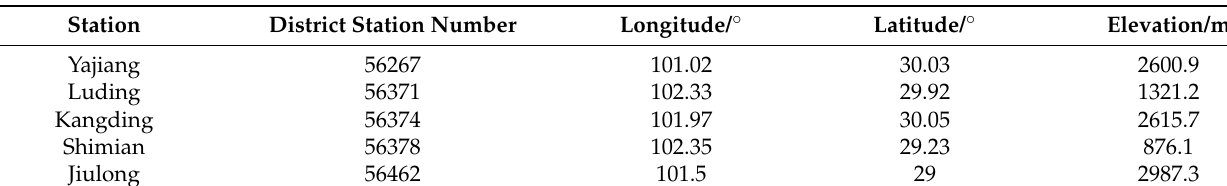
Table 4. Information on meteorological observation sites.